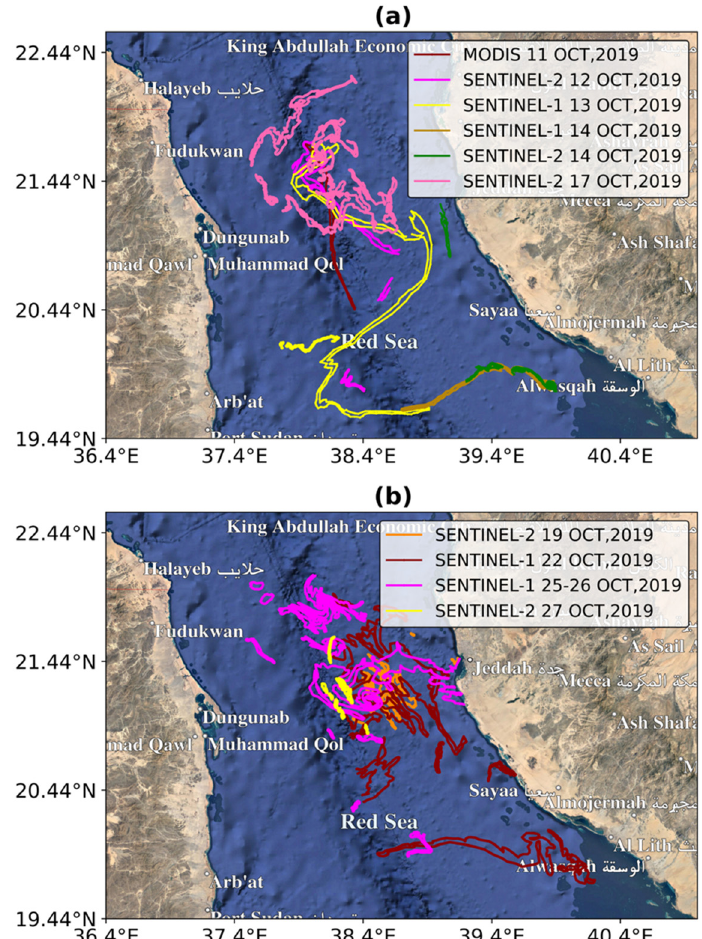
Figure 14. Spread and progression of the oil spill from the Sabiti oil tanker as inferred from the different satellite imageries shown in ( a ) from October 11 to 17, 2019 and ( b ) from October 19 to 27, 2019. The different colored lines indicate the extent of the oil spill on the different days.